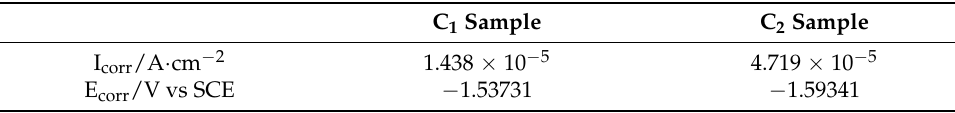
Table 2. Fitted EIS results on the basis of the equivalent circuits.